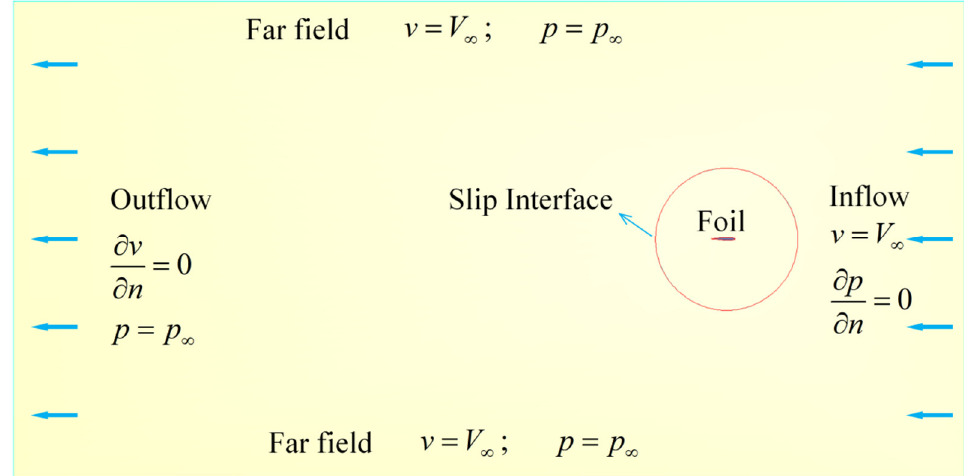
Figure 3. Schematic diagram of computational domain and boundary conditions.